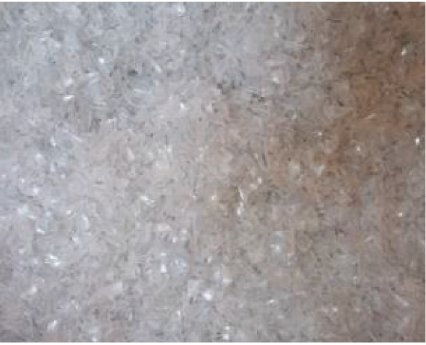
Figure 1: Second waste of plastic